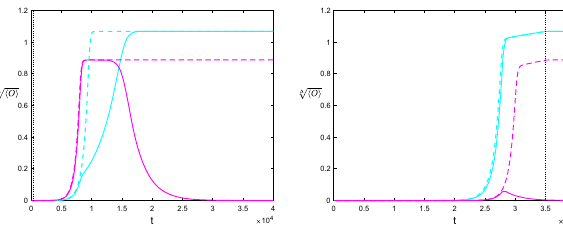
Fig. 8 The condensate values in quenching processes from the normal phase with q p = 0 . 7189. The horizontal axis is time coordinate t , while the vertical axis is the condensate value (cid:9) wave order and magenta represents p-wave order. The solid lines show the evolution of the two condensate in the s + p model, while dashed lines show the evolution of the condensate in models with single order as comparison. The left plot is for v = 0 . 0002 and the right plot is for v = 0 . 000002. The dotted vertical lines denotes the end time of quenching t f (cid:6) (cid:7) O (cid:8) at the end of the p r t f = 3 . 5 × 10 4 , respectively. We can see from the two